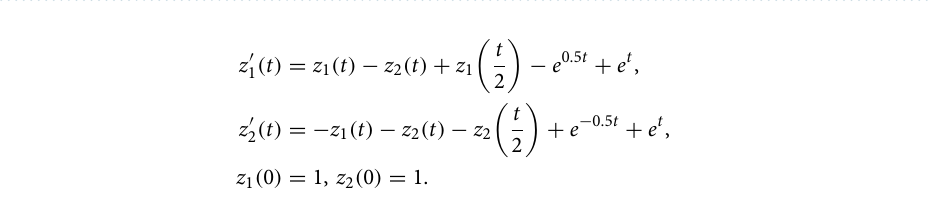
Figure 11. Error graph for different orthogonal neural networks with different numbers of neurons for Example 7.1.